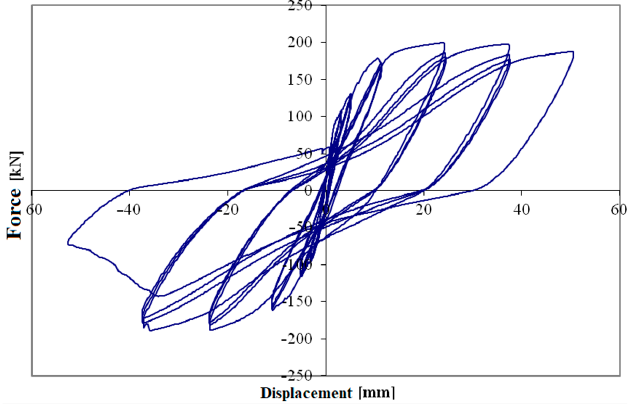
Figure 11. Load-displacement diagram of the rectangular pier test.